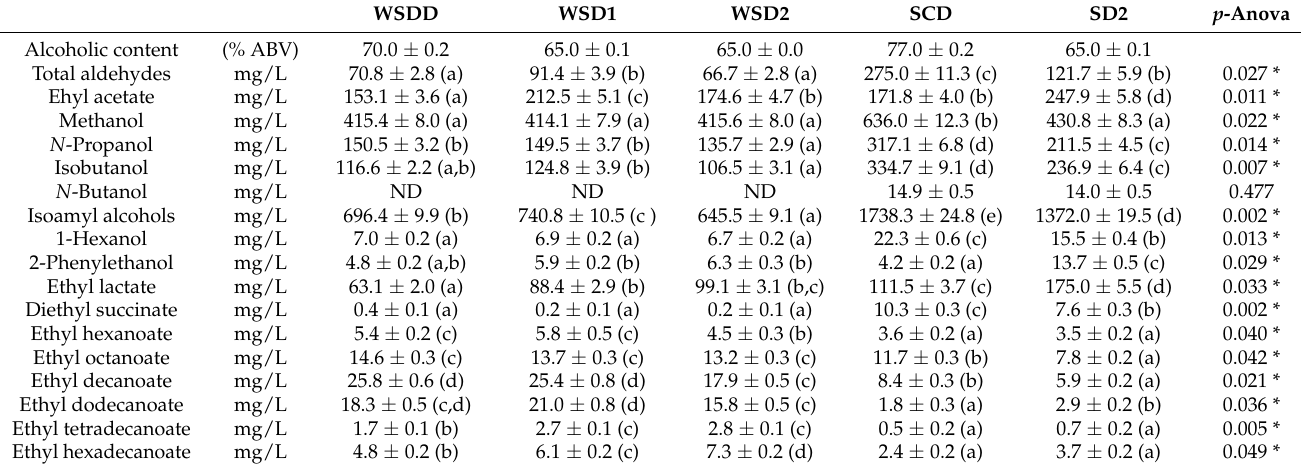
Table 3. Analytical characterization of the young spirits obtained. ND: Non detected. A different letter in parentheses indicates a significant-level difference in the sample for p < 0.05 (*). The values are expressed as the mean ± standard